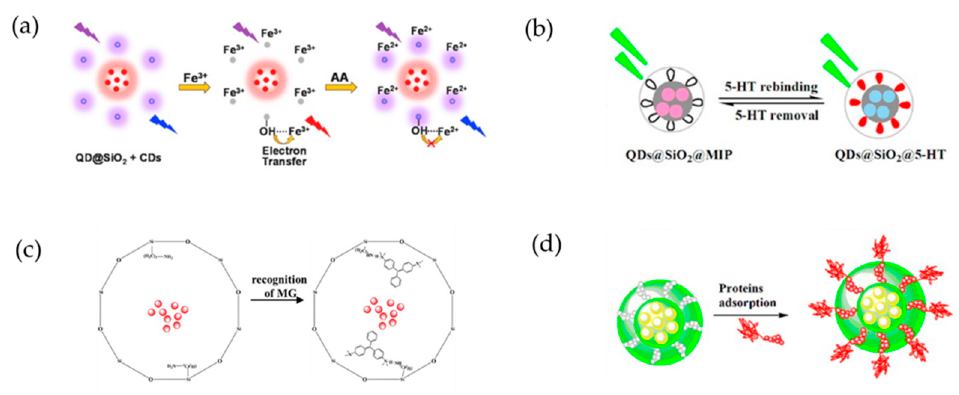
Figure 4. ( a ) Ratiometric fluorescence detection of ascorbic acid (AA) based on the “OFF” and “ON” step of a nanoprobe that contains a blue-emitting carbon dot (CD) and red-emitting, silica-coated QDs (QDs@SiO 2 ) [62]. ( b ) Fluorescence detection of serotonin (5-HT) using hybrid QDs, silica, and molecularly imprinted polymers (QDs@SiO 2 @MIPs) [63]. ( c ) Selective recognition of malachite green (MG) using MIP-coated QDs [64]. ( d ) Specific recognition and fluorescence quantification of bovine